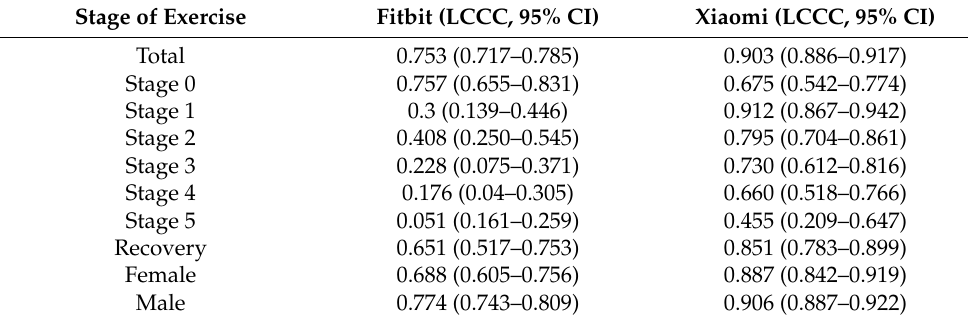
Table 4. Lin’s concordance correlation coefficient